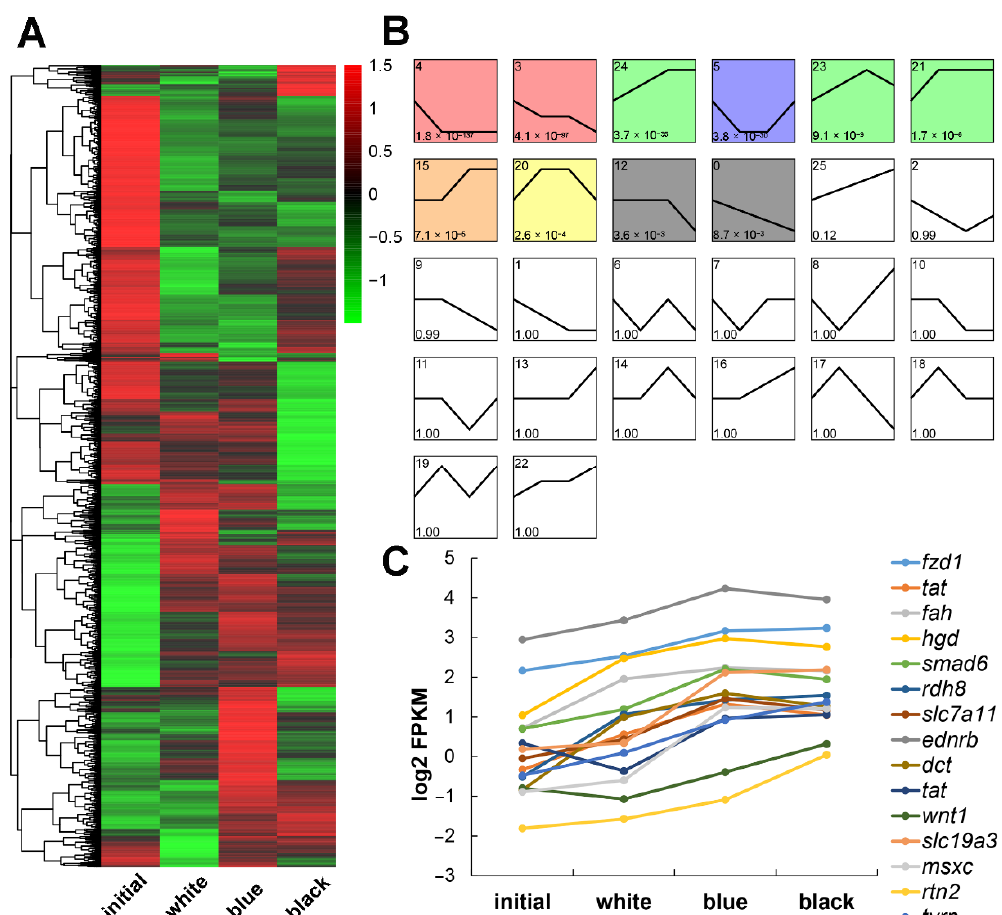
Figure 5. Hierarchical cluster analysis and expression profile of DEGs in P. leopardus of different skin colors. ( A ) The heatmap represents the log2 fold changes ( p < 0.05) of DEGs. ( B ) Expression patterns of DEGs (The colored box indicated significant difference, p < 0.05). ( C ) The specific upregulated DEGs related to the skin color from red to black.